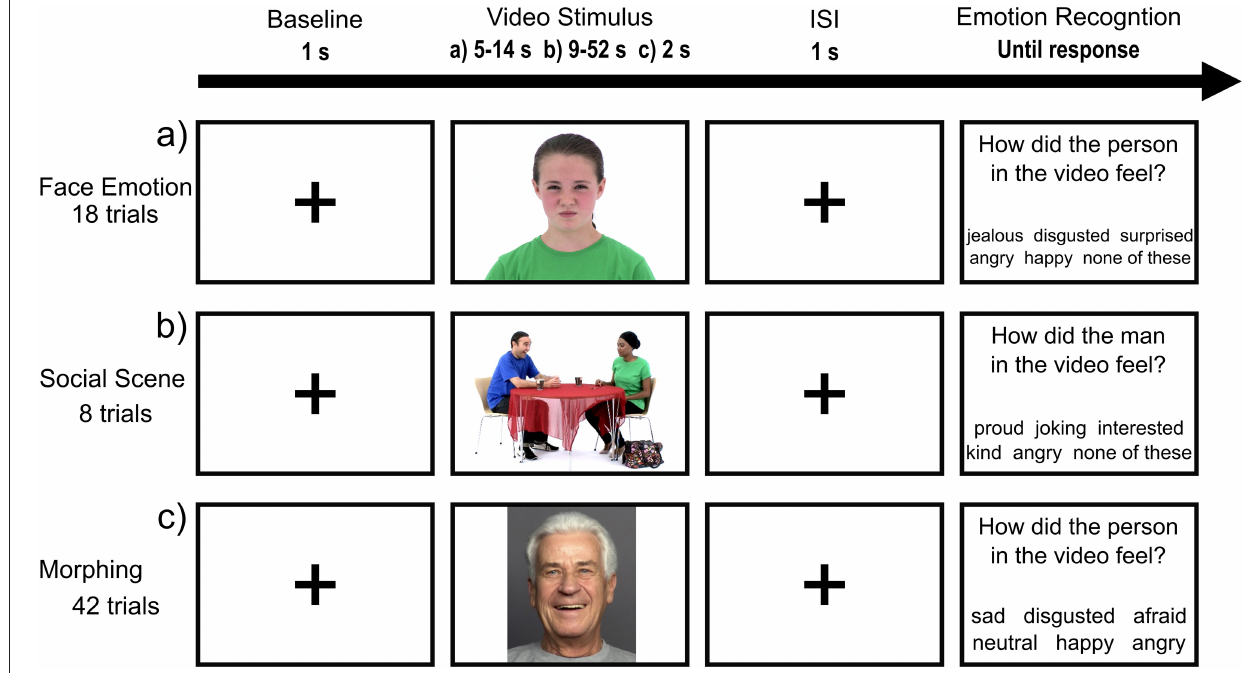
FIGURE 3 | Structure of ERT for all three parts. After the baseline (crosshair), the emotional stimuli will be presented followed by an interstimulus interval and the emotion recognition question. Part (a) shows videos of one person expressing a basic or complex emotion; (b) presents two or more people engaging in an emotional social scene; (c) consists of morphing